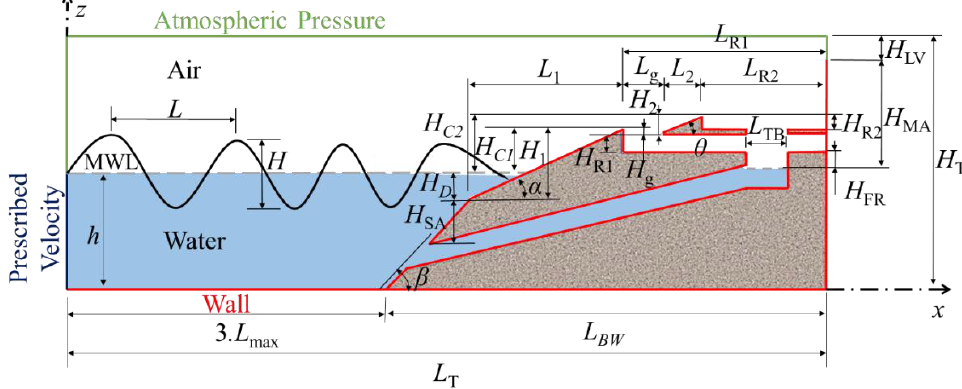
Figure 3. Illustration of the 2D computational domain for the two ramps OTD-WEC. The imposition of a velocity profile at the left inferior surface of the wave flume (Pre- scribed Velocity — blue line, Figures 2 and 3) generates irregular waves through the Joint North Sea Wave Project (JONSWAP) spectral representation model used in the present study. Furthermore, the numerical results obtained for the average dimensionless over- topping flow, Q ̅ , were compared with the average overtopping dimensionless flow equa- tion ( Q ̅ EurOtop ) [41] for inclined coastal structures (between 1:2 to 1:4/3) covered with large rocks or tetrapod, given by: